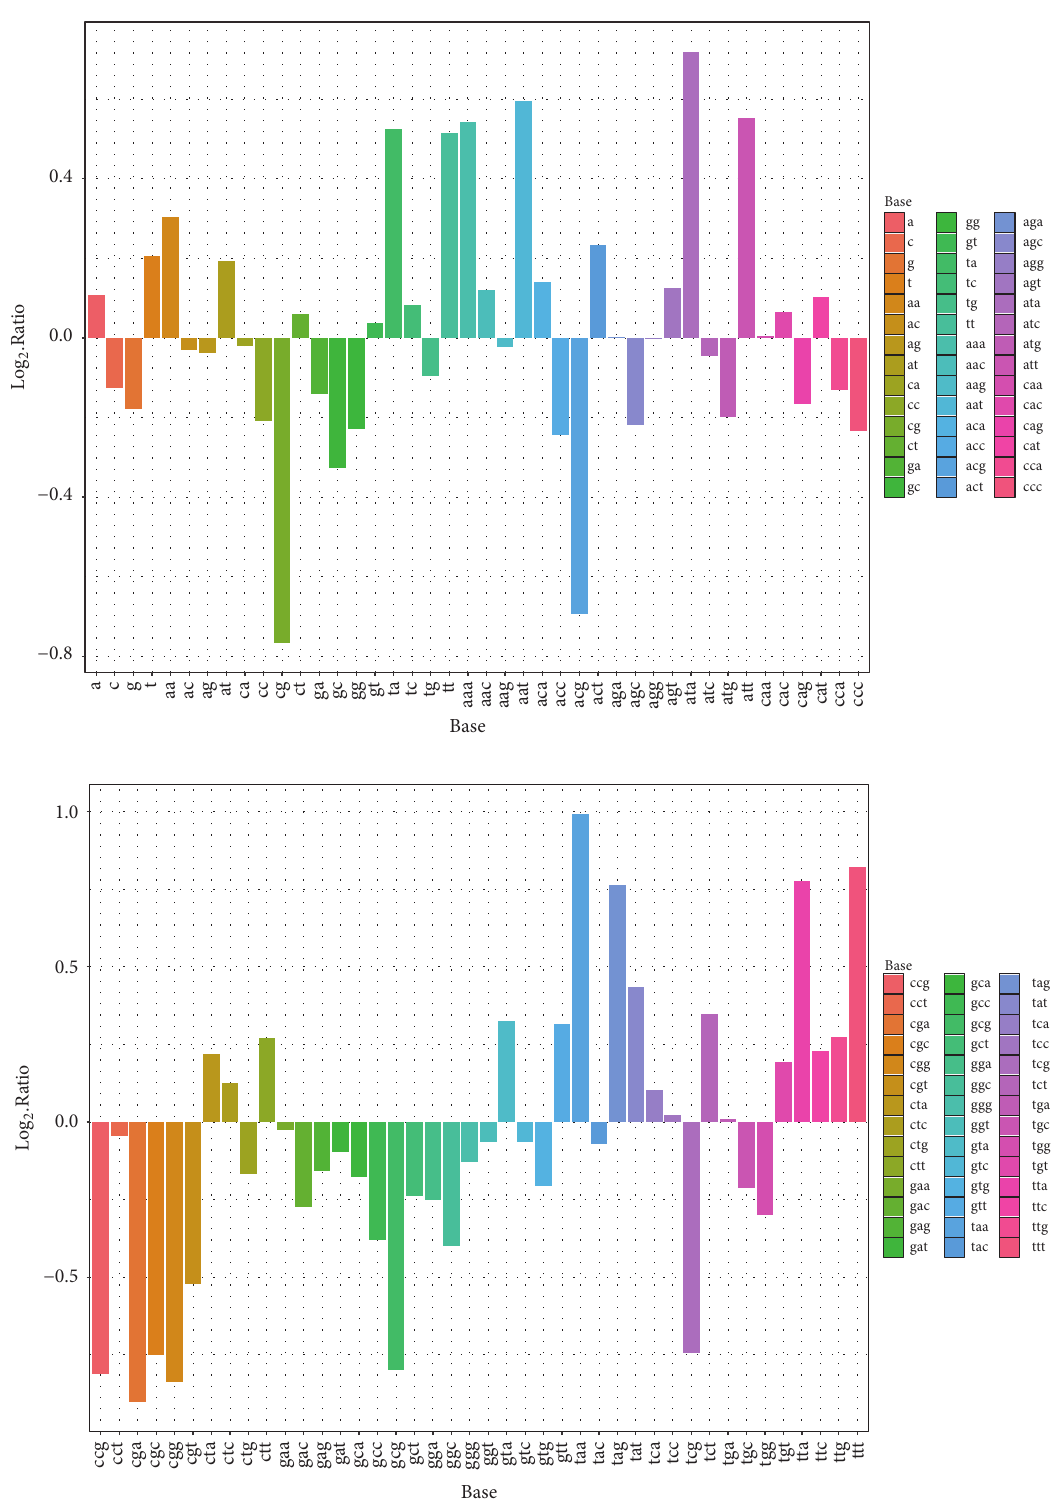
Figure 2: The distribution of the adjoining base(s) on lncRNAs and coding